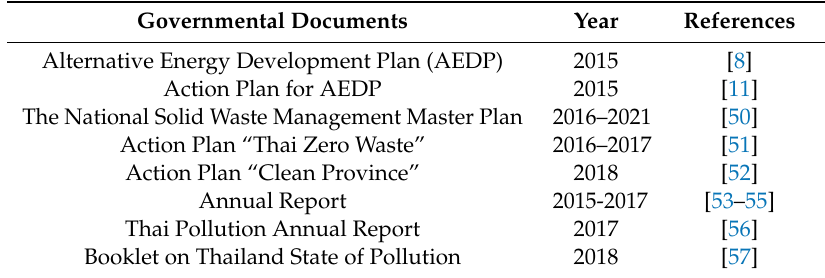
Table 3. Main sources of governmental written and electronic